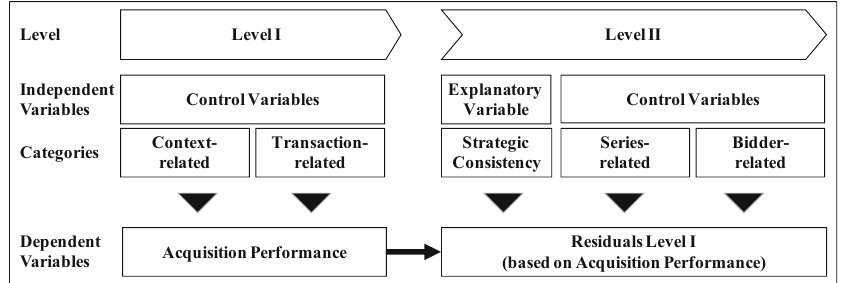
Fig. 1 Model structure and variable